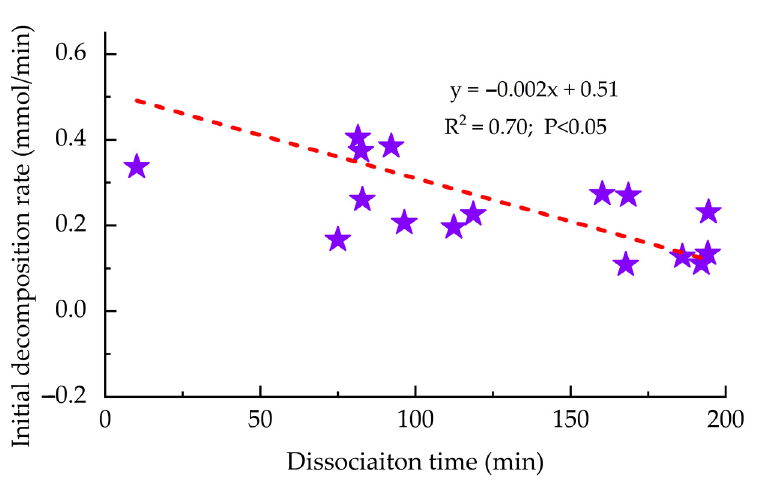
Figure 9. Relation between IDR and total dissociation time.